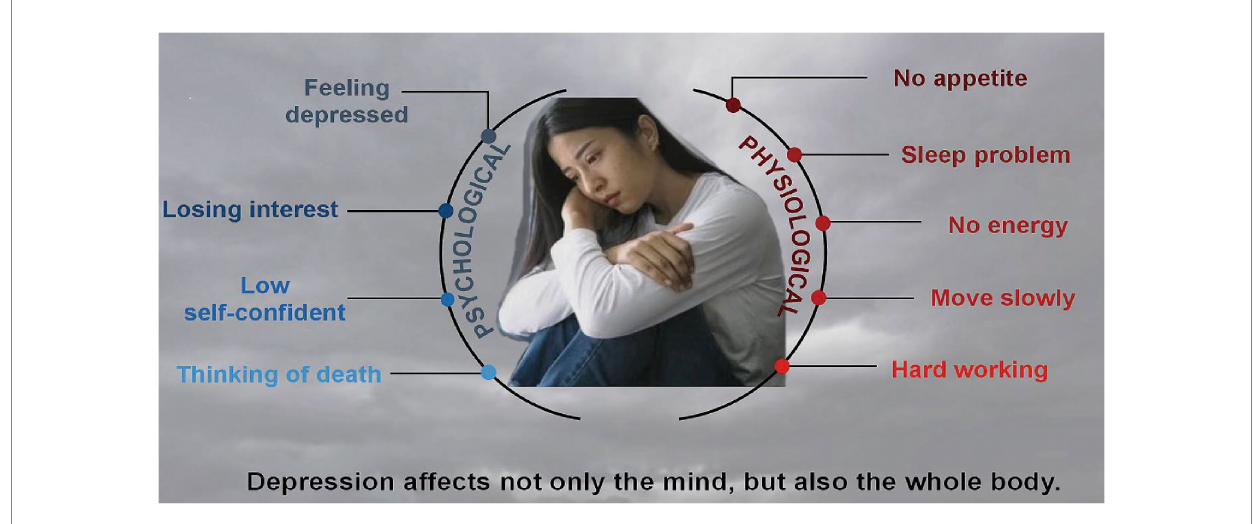
FIGURE 1 Signs and symptoms of